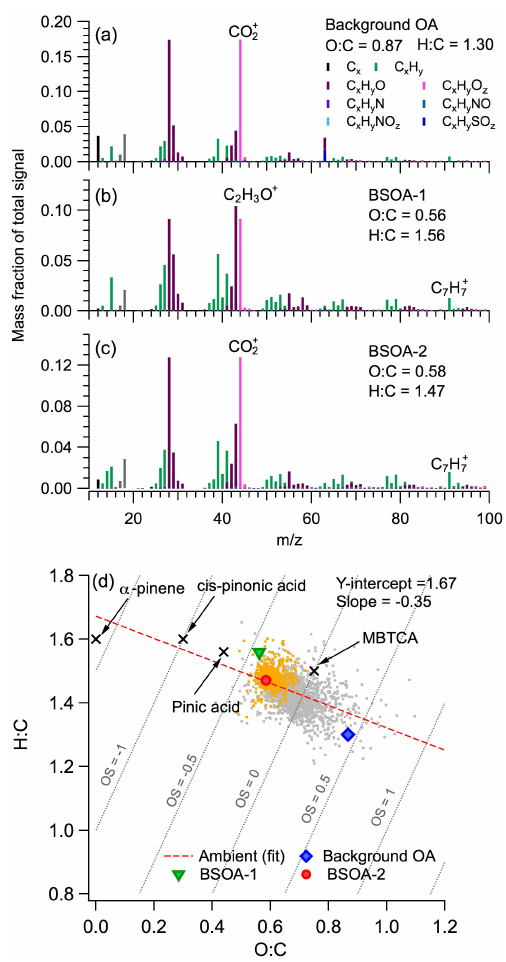
Figure 3. Normalized unit mass resolution mass spectra of PMF factors (a) background OA, (b) BSOA-1, and (c) BSOA-2. (d) Van Krevelen diagram: orange and gray dots represent observations from the regional biogenic period (6–10 July) and the whole study period, respectively. The cross symbols represent the O:C and H:C ratios of α -pinene and its major oxidation products (cis- pinonic acid, pinic acid, 3-methyl-1,2,3-butanetricarboxylic acid – MBTCA). Comparison between the Aiken’s and improved method for elemental composition analysis is shown in Fig.